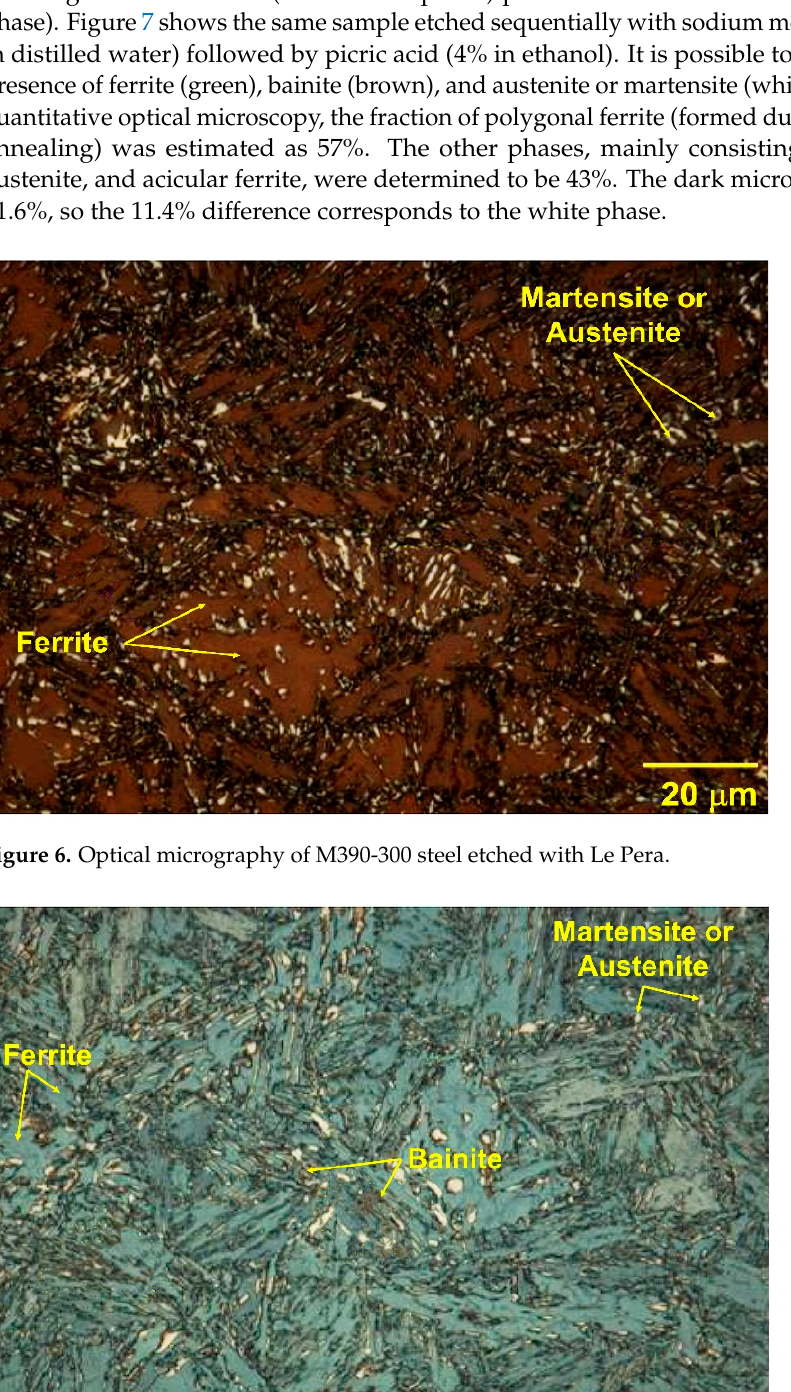
Figure 5. Variation of the carbon enrichment of austenite against temperature and soaking time